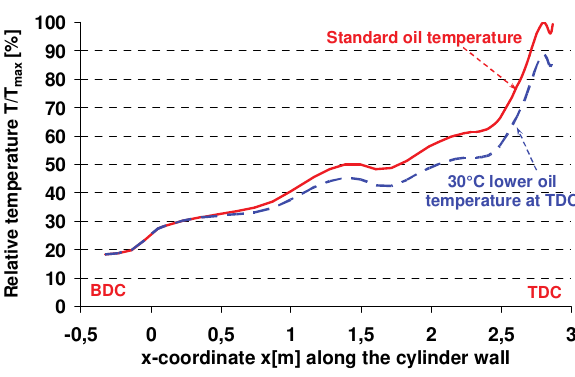
Fig. 13. Relative variations of temperature T/Tmax [%] of cylinder liner at full engine load